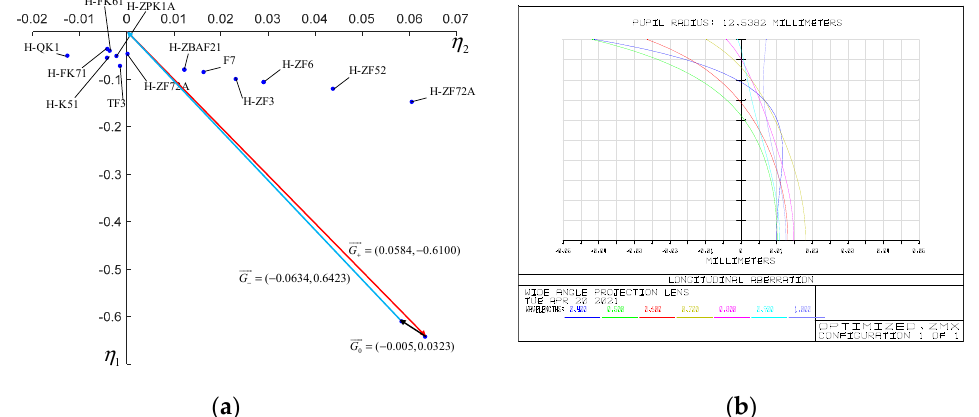
Figure 10. ( a ) Dispersion coefficient of each lens and the dispersion vector of the optimized system; ( b ) Longitudinal aberration curves of the optimized system.